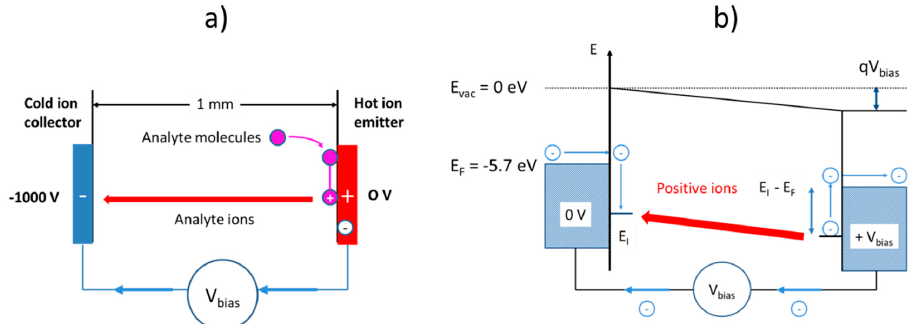
Figure 15. Surface ionization using a parallel flat-plate configuration: ( a ) Geometric electrode arrangement; ( b ) energetics of ion generation, ion transport, and ion collection.